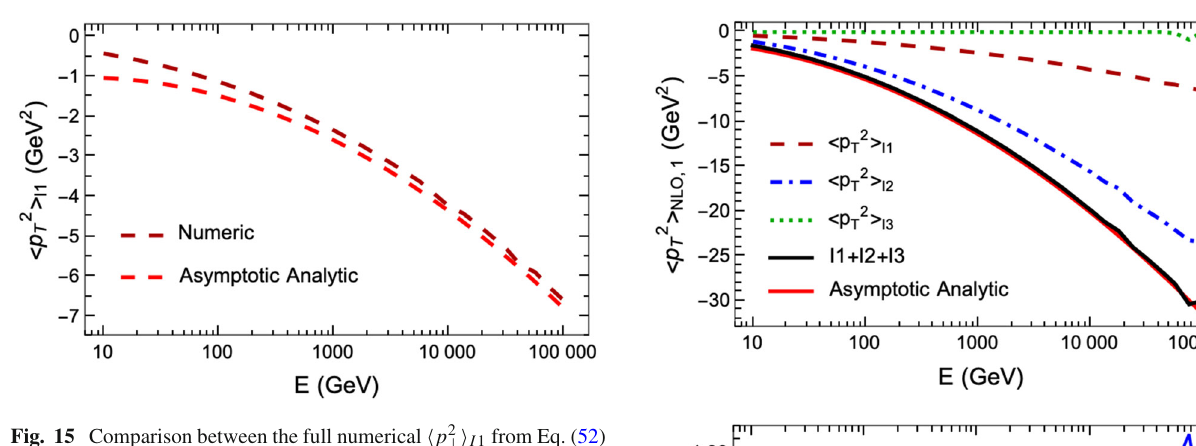
Fig. 15 Comparison between the full numerical (cid:2) p 2 ⊥ (cid:4) I 1 from Eq. (52) to the approximation Eq. (56) for L = 5 fm and μ = 0 . 5 GeV with the overall factor of C R α s L /π 2 λ restored